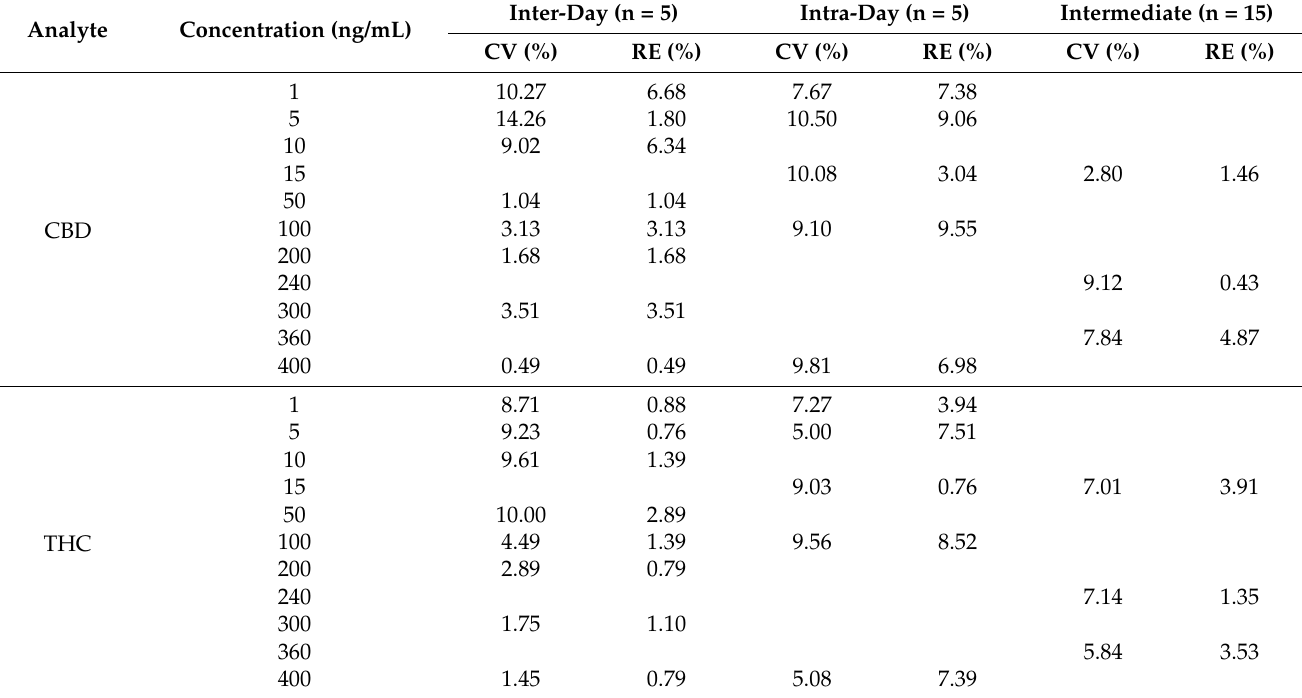
Table 3. Inter-day, intraday, and intermediate precision and